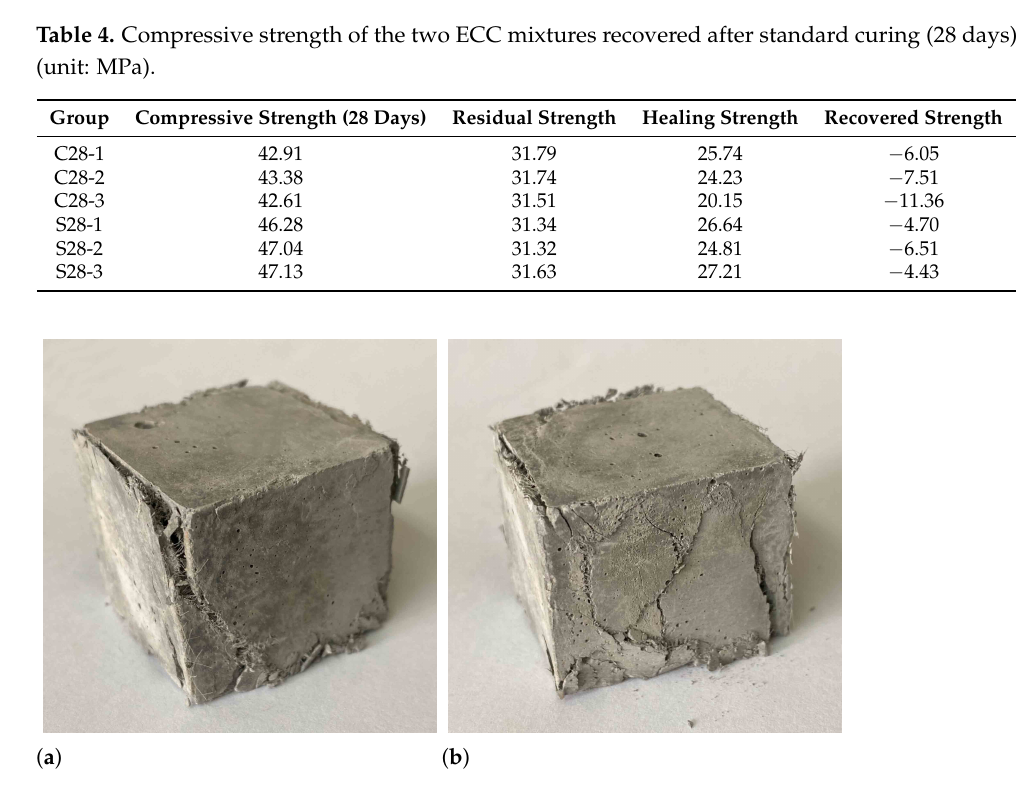
Figure 7. Comparison of final damage patterns of uniaxial compression specimens. ( a ) Control-ECC. ( b )